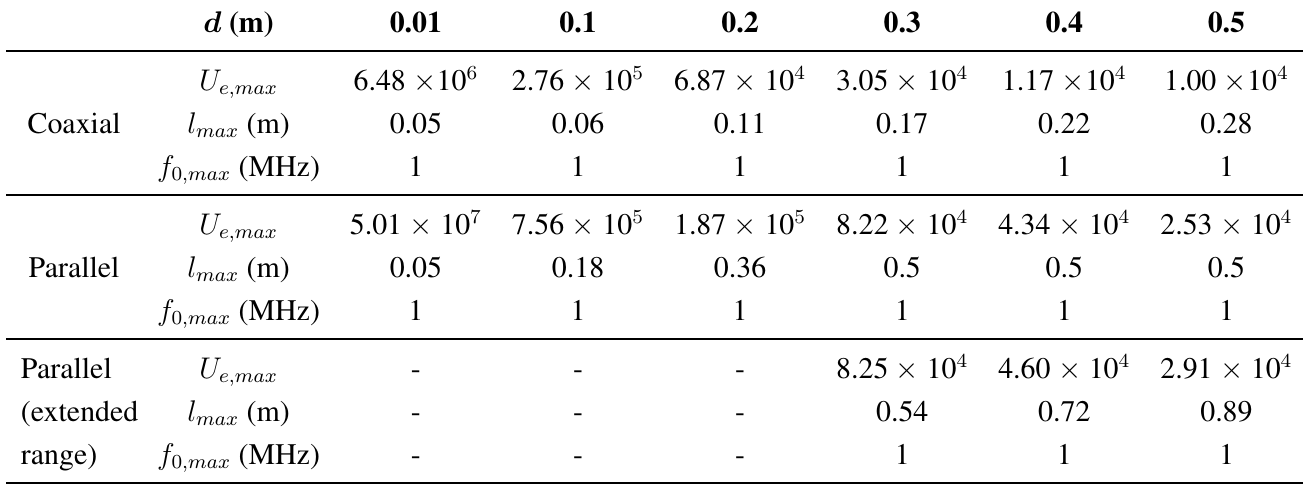
Table 2. Maximum figure of merit values, U , for the parameter sweeps of the dipole m,max system at d = 0 . 1 − 0 . 5 m for both coaxial and parallel configurations. The dipole lengths, l , and resonant frequencies, f , at which each maximum occurs are also max 0 ,max